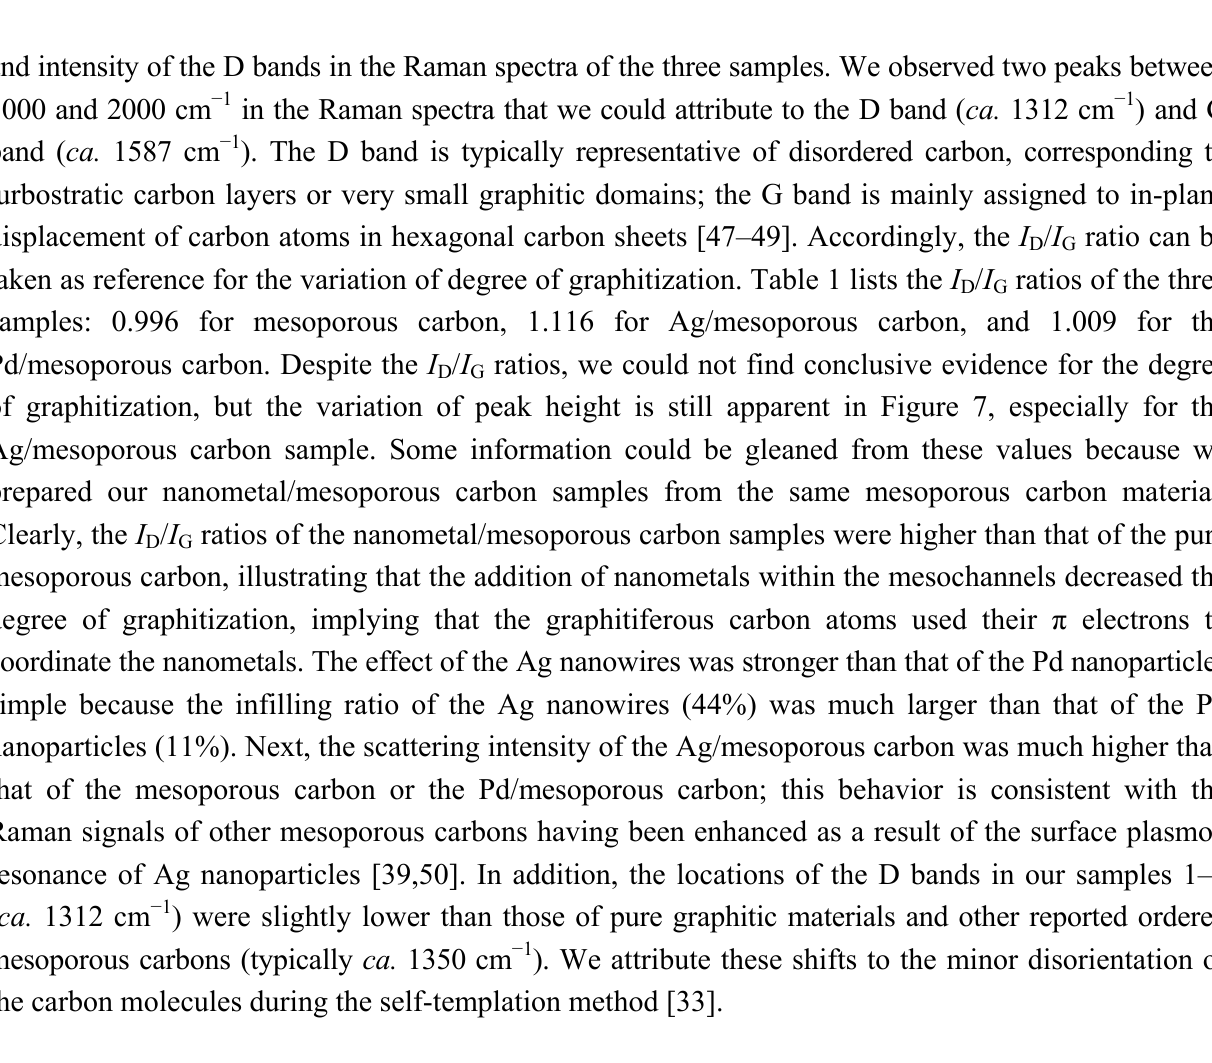
Figure 7. Raman spectra of mesoporous carbon (black line), Pd/mesoporous carbon (red line), and Ag/mesoporous carbon (blue